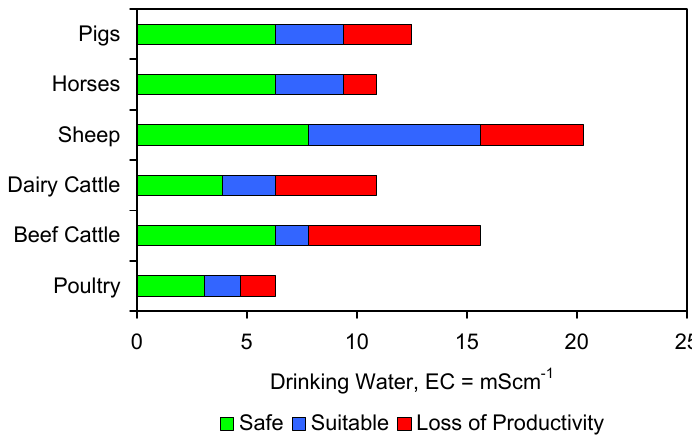
Figure B2. Variation in livestock yields with drinking water salinity. Data: [210–214].